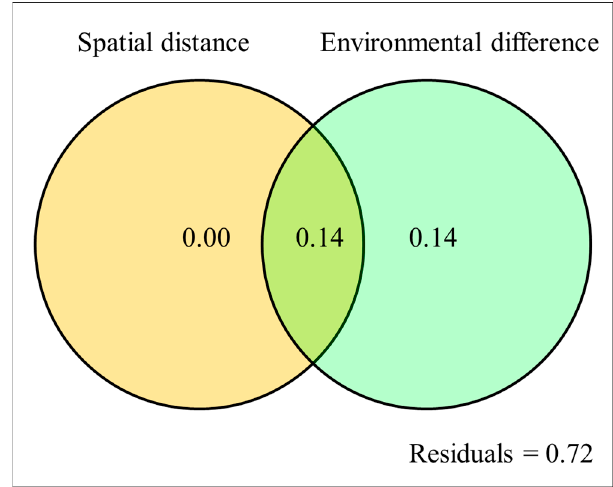
Figure 5. The contribution of spatial distance and environmental difference to NDEP based on Variance Partitioning Analysis. The left yellow circle represents spatial distance, and the right green circle represents environmental difference.